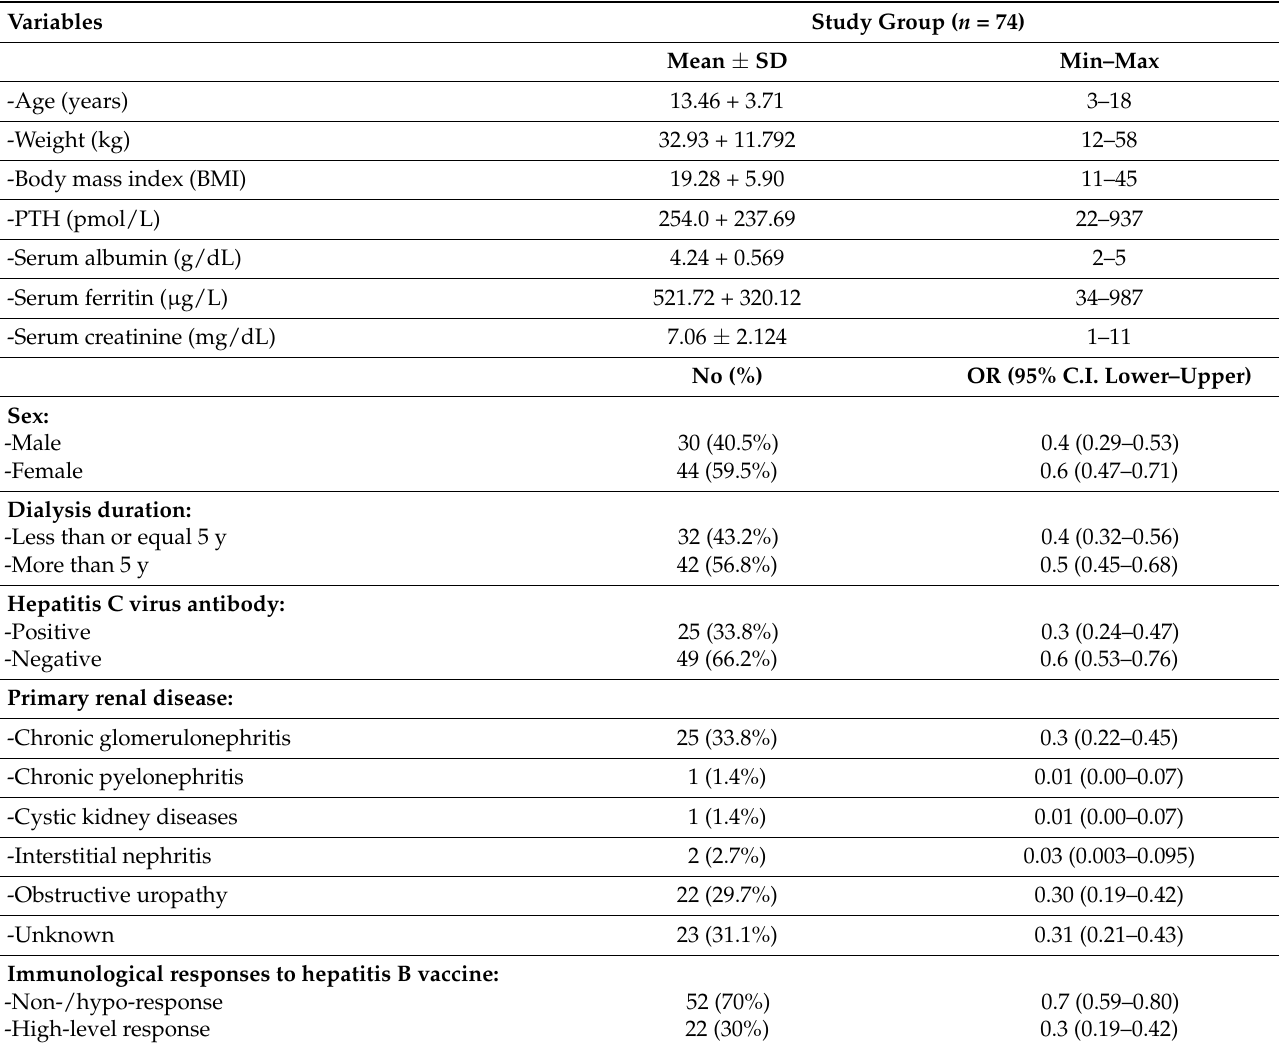
Table 2. Demographic and clinical characteristics of the samples